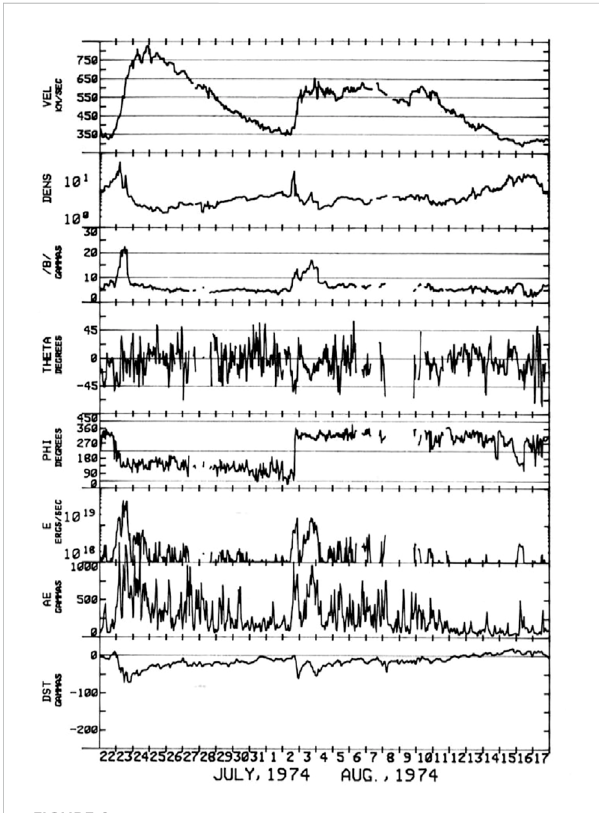
FIGURE 9 A typical example of solar wind observations in 1974. From the top,thesolarwindspeed,density,IMFmagnitude B ,IMFanglesTHETA andPHI,thesolarwind-magnetospheredynamopower ε (seeAkasofu et al. (1988)), and geomagnetic indices AE and